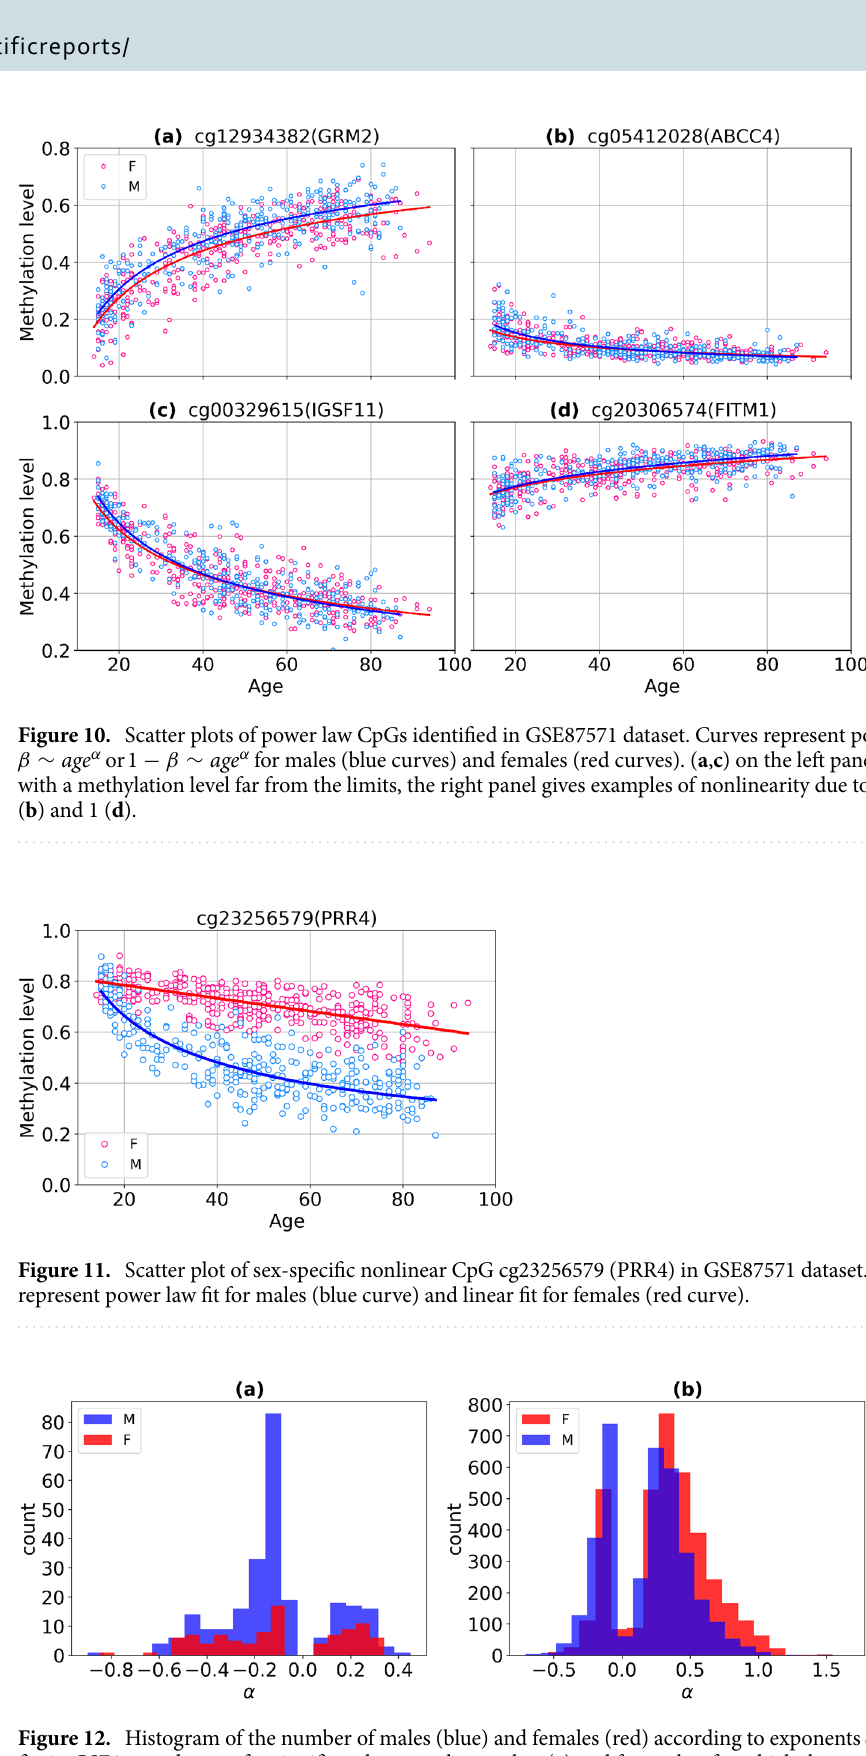
Figure 12. Histogram of the number of males (blue) and females (red) according to exponents α of power law fits in GSE87571 dataset: for significantly power law probes ( a ) and for probes for which the power law and linear fits are weakly distinguishable ( b